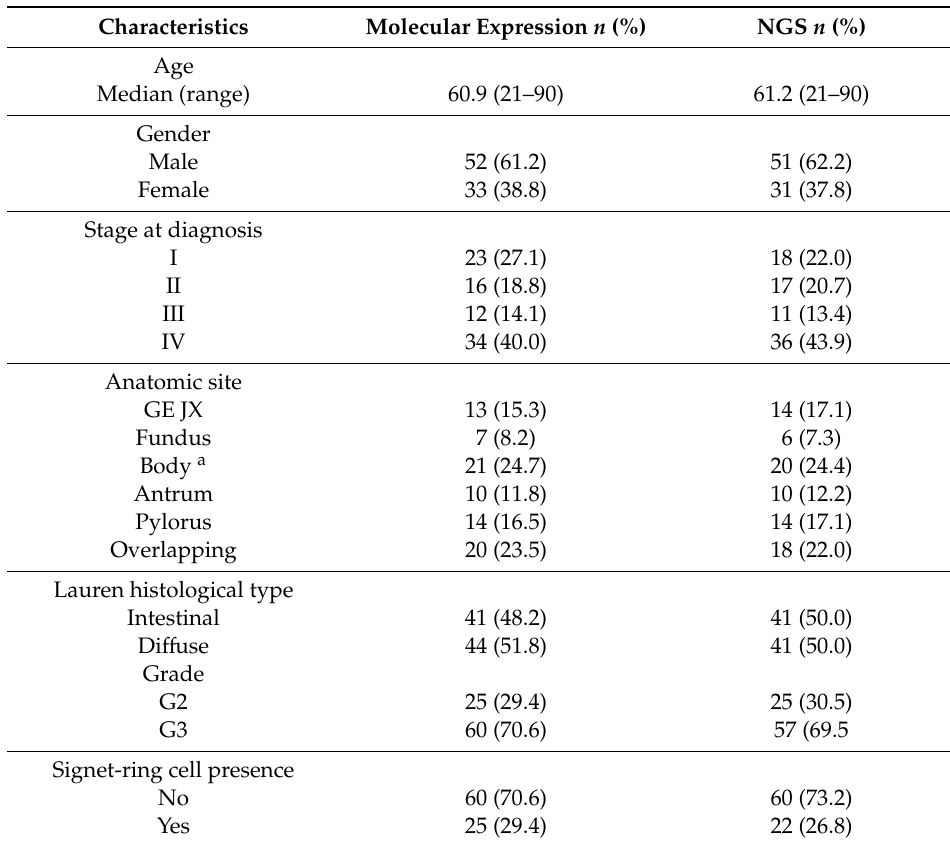
Table 1. Demographic, clinical, and pathological characteristics of Alaska Native (AN) gastric